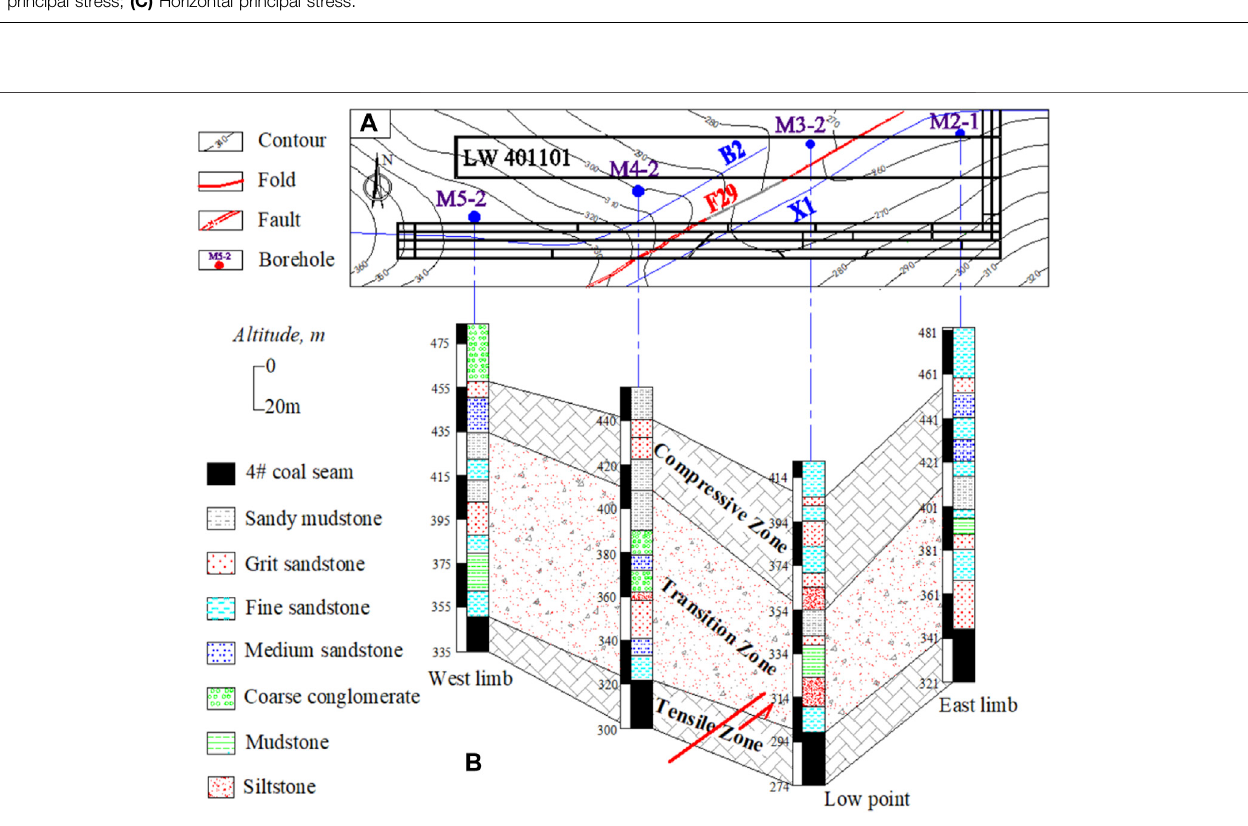
FIGURE 3 | Stratigraphic map of the coupled fault-fold region near the 401101 working face. (A) Geological exploration boreholes of LW 401101; (B) Regional stratigraphic sediment characteristics.